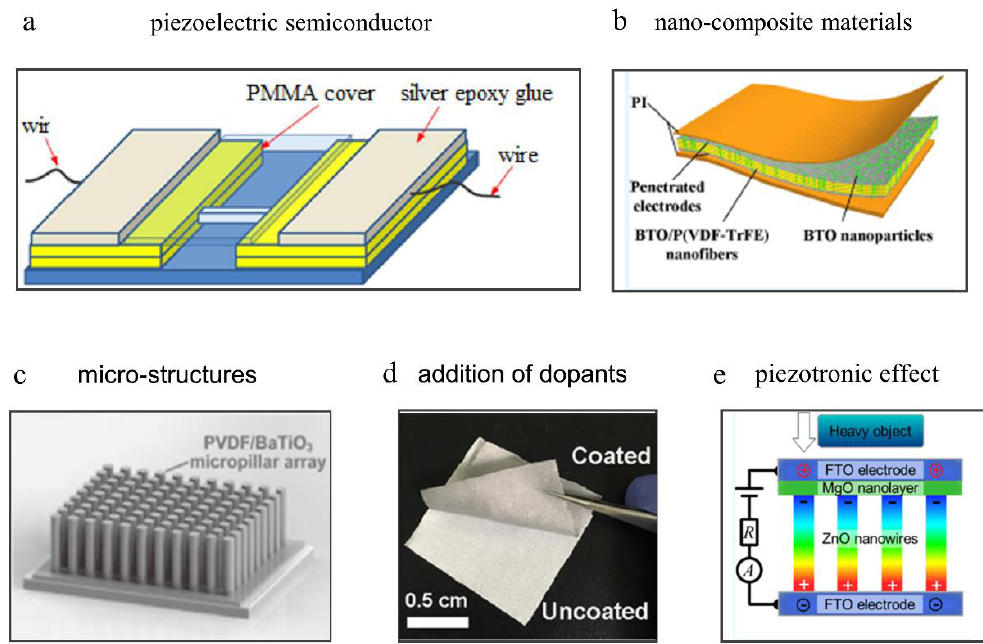
Figure 2. Different strategies facilitating high-performance flexible piezoelectric sensors. ( a ) material innovation: a ZnO-based piezoelectric sensor. Copyright from Springer Nature. ( b ) material innovation: a piezoelectric sensor based on nanocomposite materials. Copyright from ACS. ( c ) Designing microstructures: A piezoelectric sensor based on micropillar array. Copyright from John Wiley and Sons. ( d ) addition of dopants: a piezoelectric sensor based on phase-separation-induced PVDF / graphene coating on fabrics. Copyright from ACS ( e ) piezoelectric sensors based on piezotronic effect: a pressure sensor based on vertically well-aligned ZnO nanorods. Copyright from ACS.